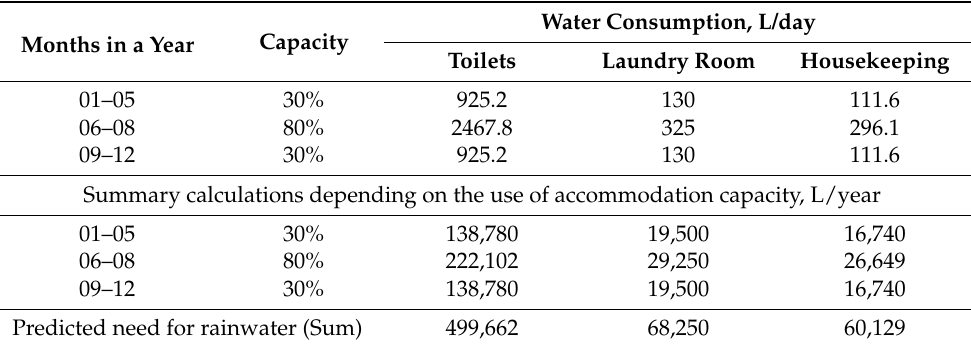
Table 3. A quantification of input data on rainwater